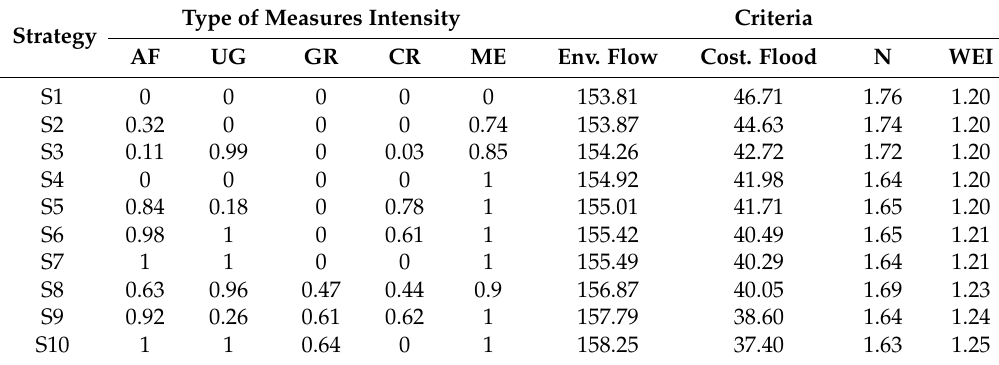
Table 5. Pareto PoM obtained according to N, WEI and Environmental flow criteria for the Danube catchment considering the flooding-related family of abatement measures (AF: afforestation, UG: urban greening, GR: grassland, CR: crop practices, ME: re-meander). Cost flood in 1000 € /km 2 .